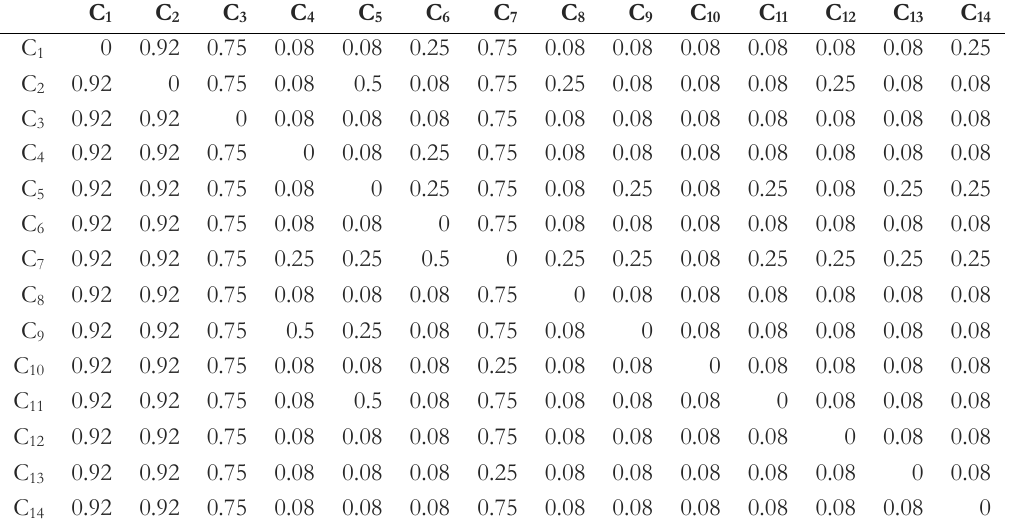
Table 4. The modified connection